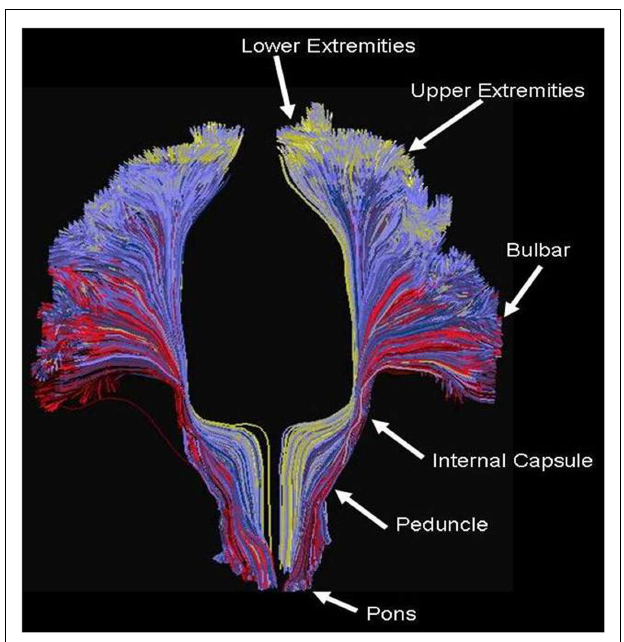
FIGURE 5 | Example of tractography using the method developed for this work, using as a seed the cortical spinal tract at the level of the central pons, and displaying all tracts connecting that location to all voxels located in the precentral gyrus . Each path is color-coded by the strength of the global connectivity score as described in the Data Sheet 1 in Supplementary Material (yellow-green represents high structural connectivity; blue is intermediate; red is low).The method recapitulates the known set of pathways connecting both medial and lateral aspects of the precentral gyrus, and is not significantly affected by crossing fibers from the transcallosal and superior longitudinal